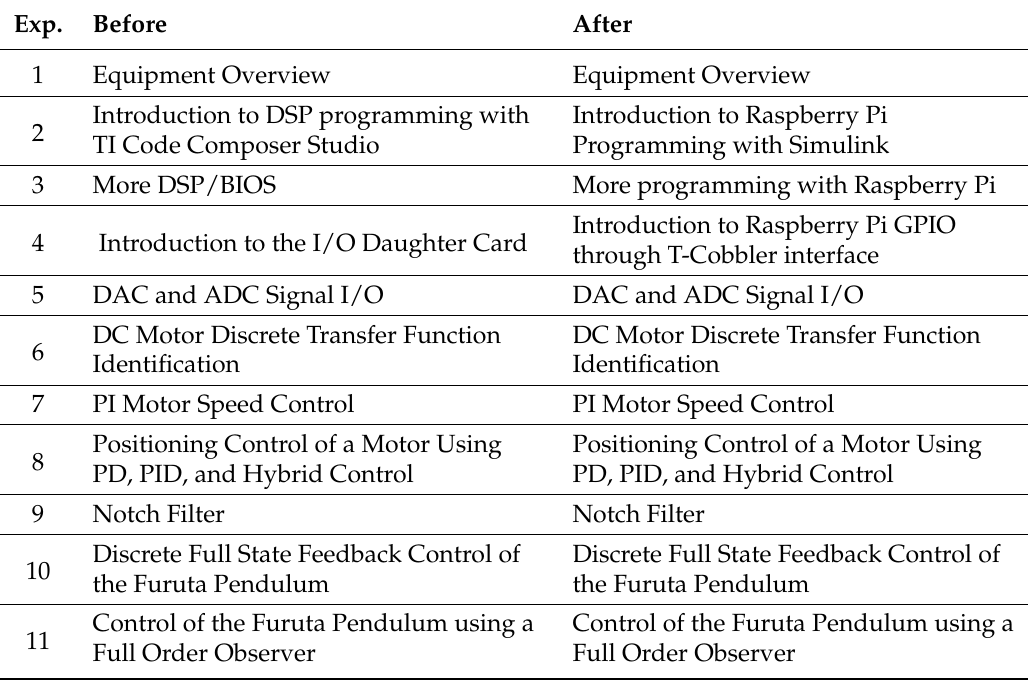
Table 3. Comparison of GE 420